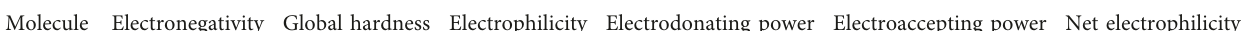
Table 6: Global reactivity descriptors (in eV) for the astaxanthin pigment calculated with the MN12SX and N12SX density functionals and the Def2TZVP basis set using the four solvents, simulated with the SMD parametrization of the IEF-PCM model. MN12SX